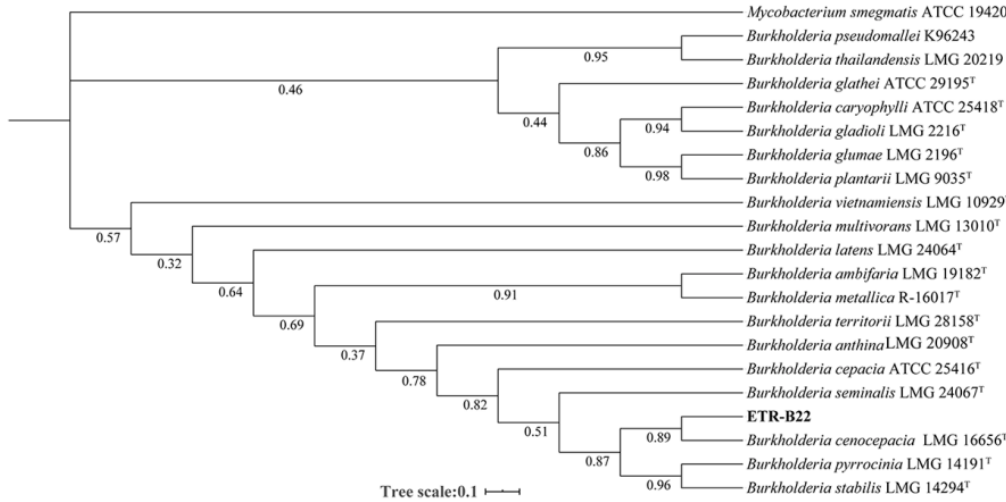
Figure 1. The Bayesian phylogenetic tree from the combined sequences of the16S rRNA and recA gene of strain ETR-B22 and type strains of the Burkholderia group. The tree is rooted with sequences of Mycobacterium smegmatis ATCC 19420. BI posterior probability (PP) is shown below the branch around the corresponding node. Strain ETR-B22 is highlighted in bold.